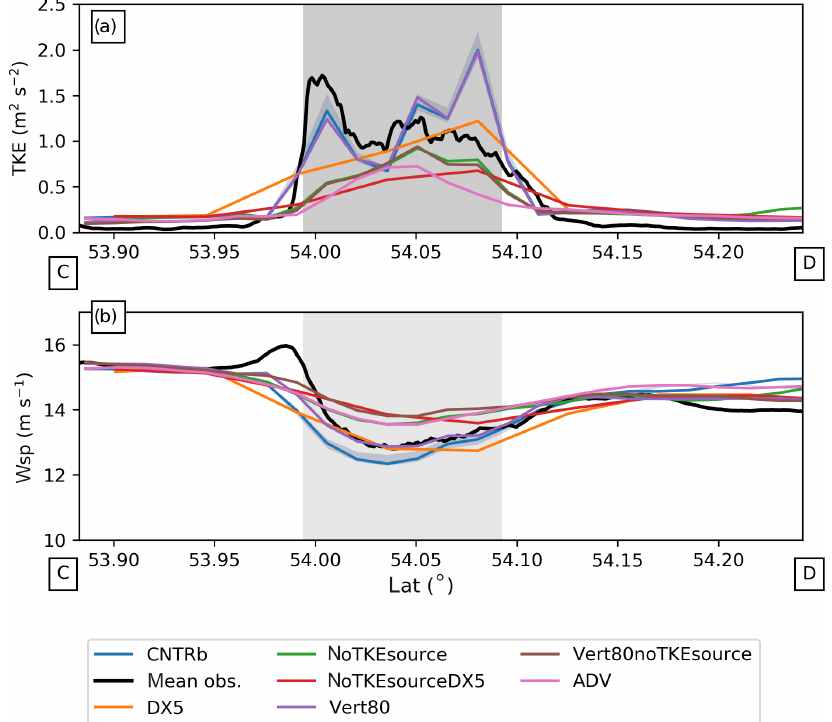
Figure 11. As in Fig. 8 but for TKE (a) and wind speed (b) for the sensitivity simulations DX5, noTKEsource, DX5noTKEsource, Vert80, Vert80noTKEsource and ADV conducted for case study II at 15:00UTC. A summary of all sensitivity tests is listed in Table 2. For better comparison, the control simulation CNTRb is plotted as